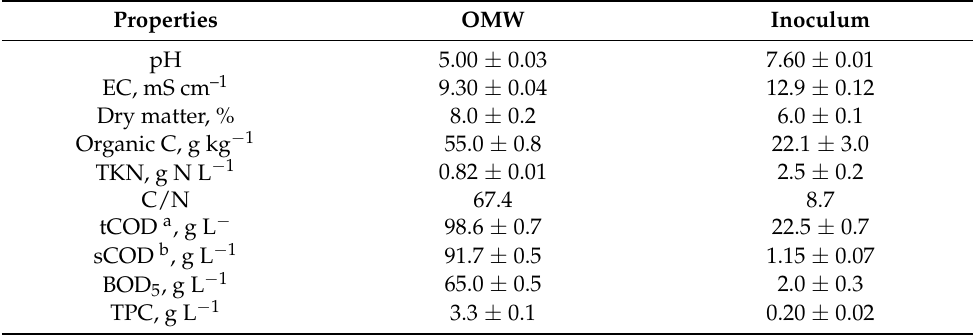
Table 1. Chemical characterization of olive mill wastewater and